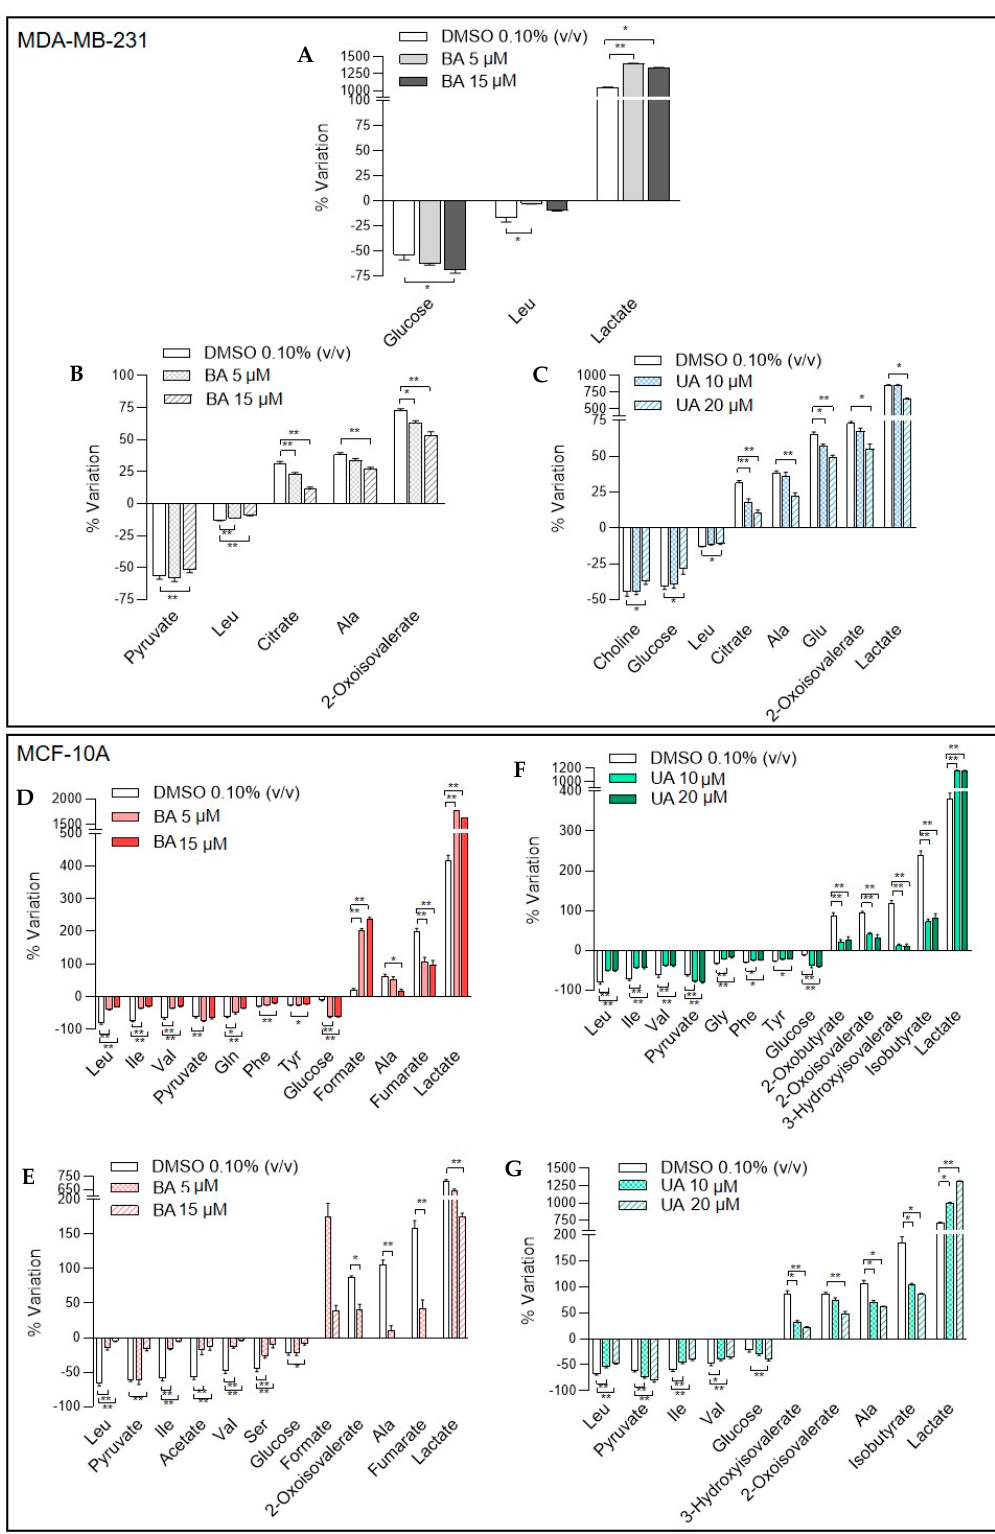
Figure 3. Variations in metabolites consumed (negative bars) and excreted (positive bars) by cells upon exposure to triterpenic acids (TAs), as assessed by comparison to acellular culture media. Consumption and excretion patterns are shown for control cells and: ( A ) MDA-MB-231 treated with betulinic acid (BA) for 48 h, ( B ) MDA-MB-231 treated with BA for 48 h followed by 24 h recovery in fresh medium, ( C ) MDA-MB-231 treated with ursolic acid (UA) for 48 h followed by 24 h recovery in fresh